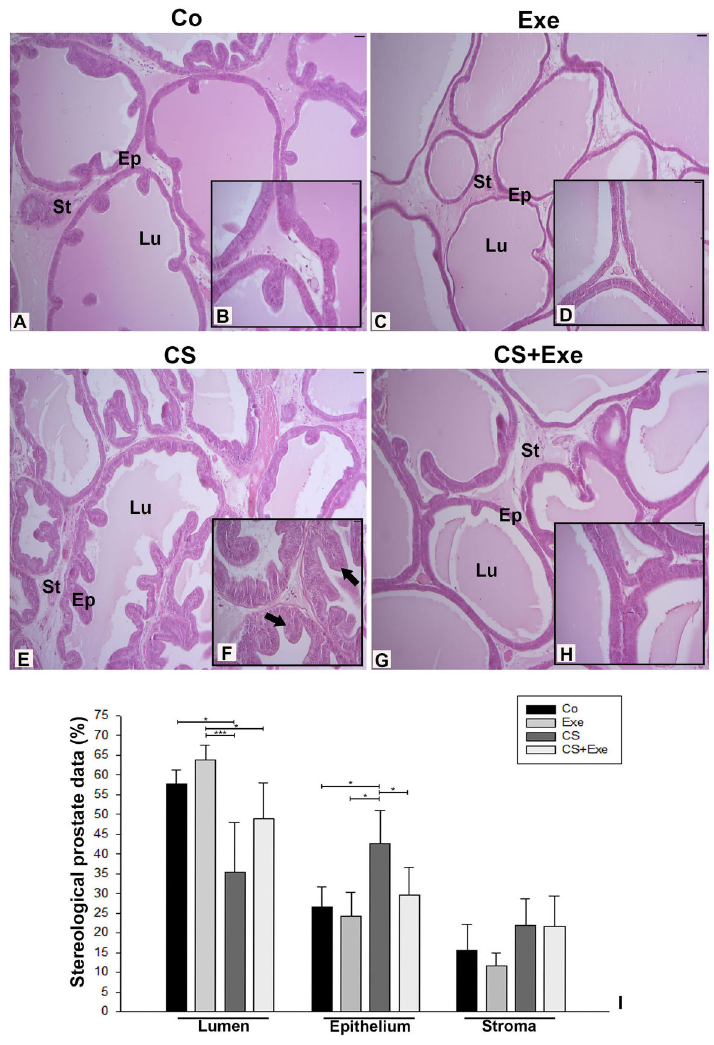
Figure 2. Histological analysis and quanti fi ca- tion of stereology in the ventral prostate as a percentage of total prostate surface area from Wistar rats in the control group (Co) (n=10, A and B ), exercise only group (Exe) (n=10, C and D ), smoke exposure only group (CS) (n=8, E and F ), and exercise with smoke exposure group (CS + Exe) (n=10, G and H ). Images were captured at 10 (cid:1) magni fi cation (scale bars, 50 m m) and enlarged to 40 (cid:1) magni fi cation (scale bars, 20 m m) in the insets. Arrows indicate locations with prostatic intraepithelial neoplasia. Data are re- ported as mean percentage of surface area ± SD. The Weibel reticle of 160 points was used for morphometric analysis and the stereology (acini, epithelium, and stroma) of prostate cross-sections were quanti fi ed across 10 images per slide, with 10 slides analyzed per prostate